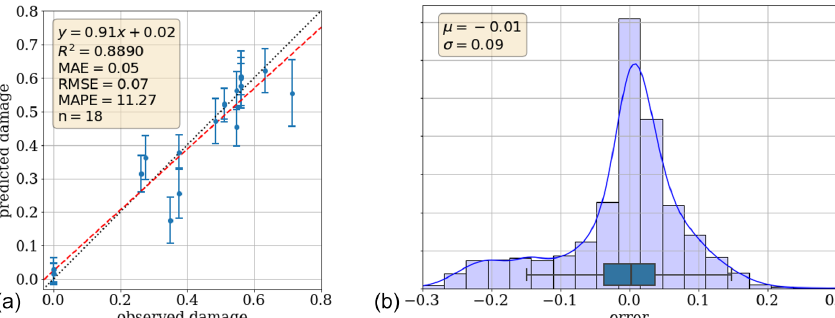
Figure 12. Model comparison : (a) one-to-one comparison of ensemble predictions and the true observed damage (both encoded). The error bars indicate the ensemble standard deviation, the dashed red line shows the best linear fit, and the dotted black line shows the results of a perfect prediction as a reference. (b) Error distribution of the 2448 predictions based on all subsets; i.e., each sample is predicted by multiple individual models.